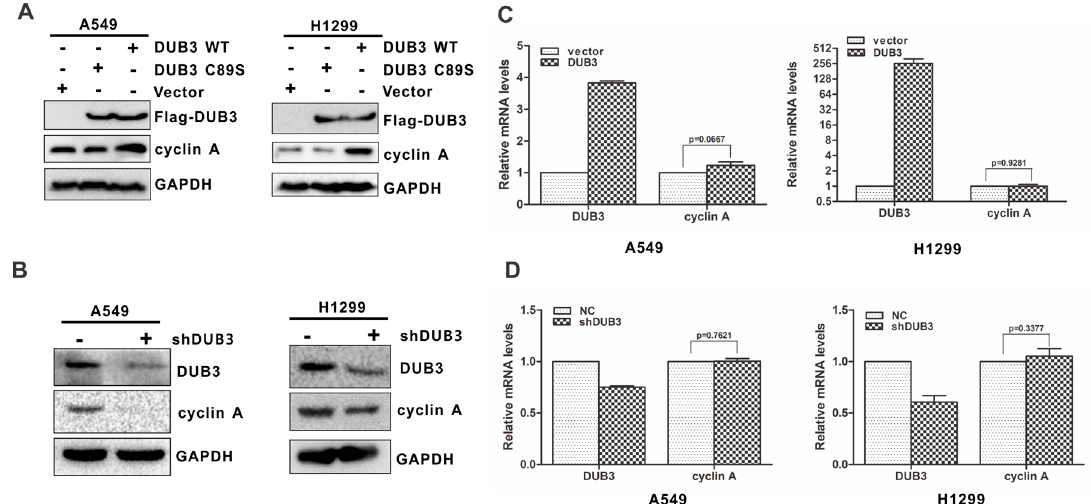
Figure 1. DUB3 influences the protein level of cyclin A. ( A ) A549 and H1299 cells were transfected with the indicated constructs. Total protein was extracted and subjected to Western blotting using anti-Flag, anti-cyclin A or anti-GAPDH antibody. ( B ) A549 and H1299 cells were infected with indicated lentiviral shRNA. The resulting cell extracts were analyzed using Western blotting with anti-DUB3, anti-cyclin A or anti-GAPDH antibody. ( C ) A549 and H1299 cells were transfected with a plasmid encoding Flag-DUB3 or an empty vector control. Total RNA was isolated and subjected to real-time PCR. ( D ) A549 and H1299 cells were infected with indicated lentivirus encoding the DUB3 shRNA or control shRNA. Total RNA was isolated and subjected to real-time PCR. The error bars represent the SD of triplicate measurements.